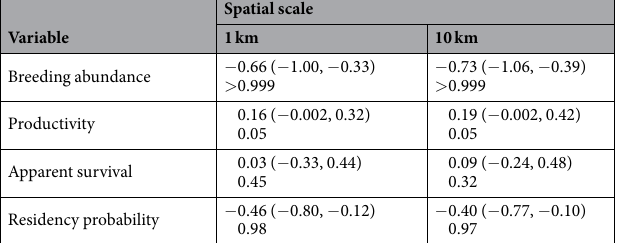
Table 4. Model coefficients showing the influence of disturbance (based on human footprint indices) at 1 km and 10 km radius scales around MAPS stations on breeding abundance, productivity, apparent survival and residency probability of Canada warblers. Values shown include the mean and 90% credible interval from the posterior distribution with the probability of a negative effect